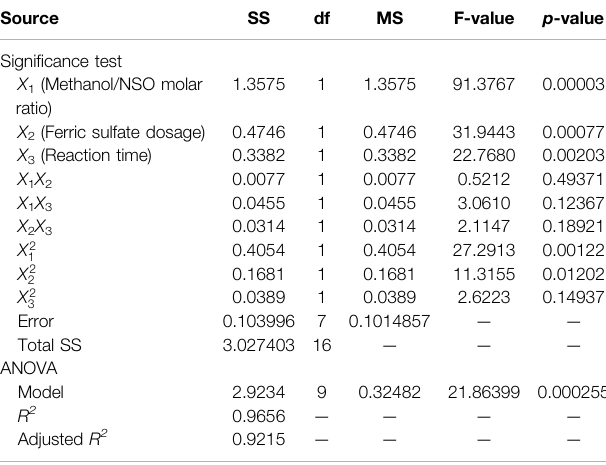
TABLE 6 | Univariate test of signi fi cance for regression coef fi cients and ANOVA. Source SS df